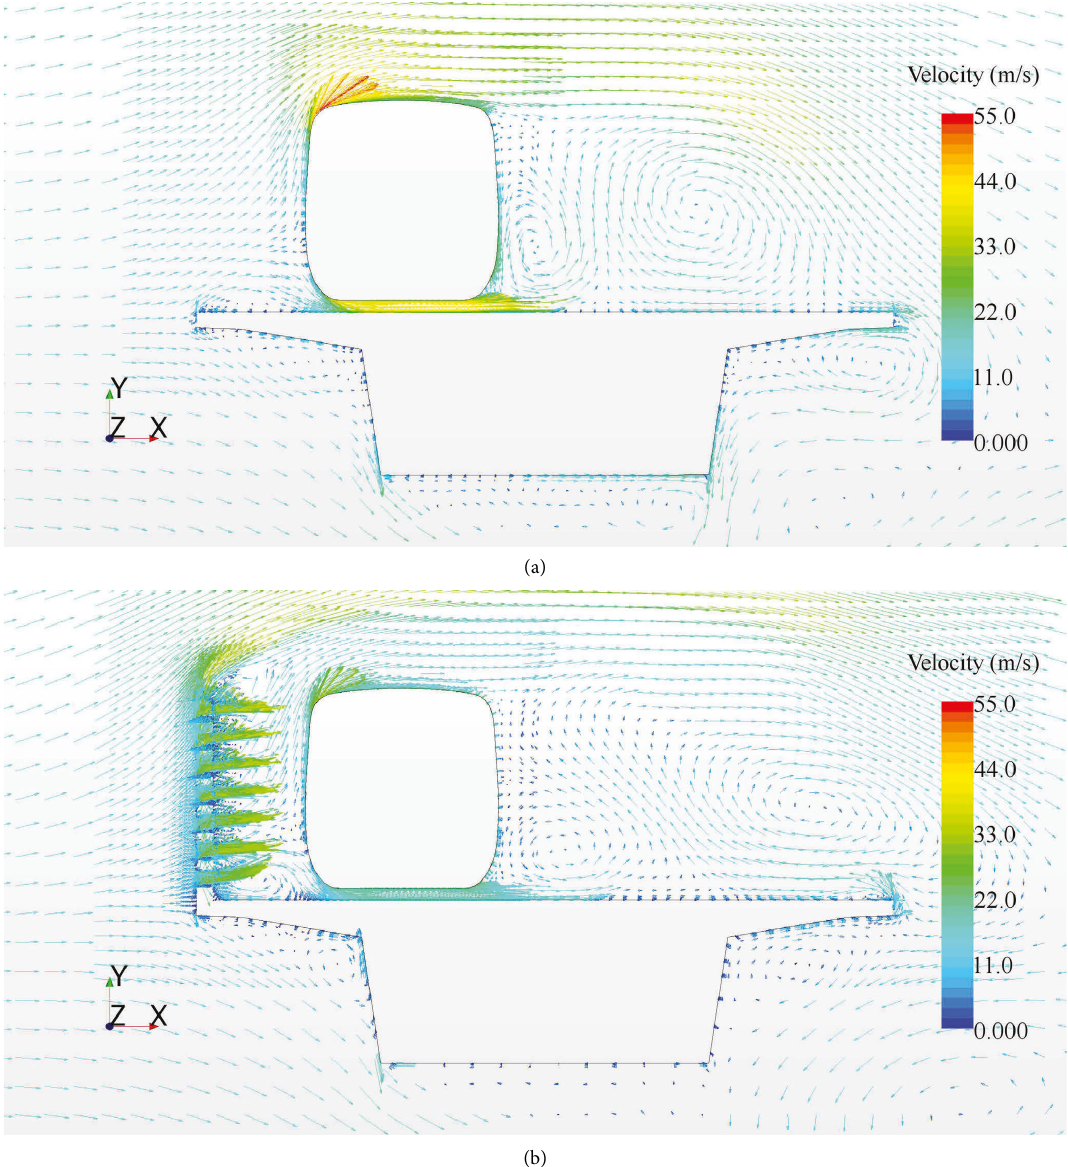
Figure 9: Velocity vectors of train-bridge system: (a) with no wind barrier and (b) with a wind